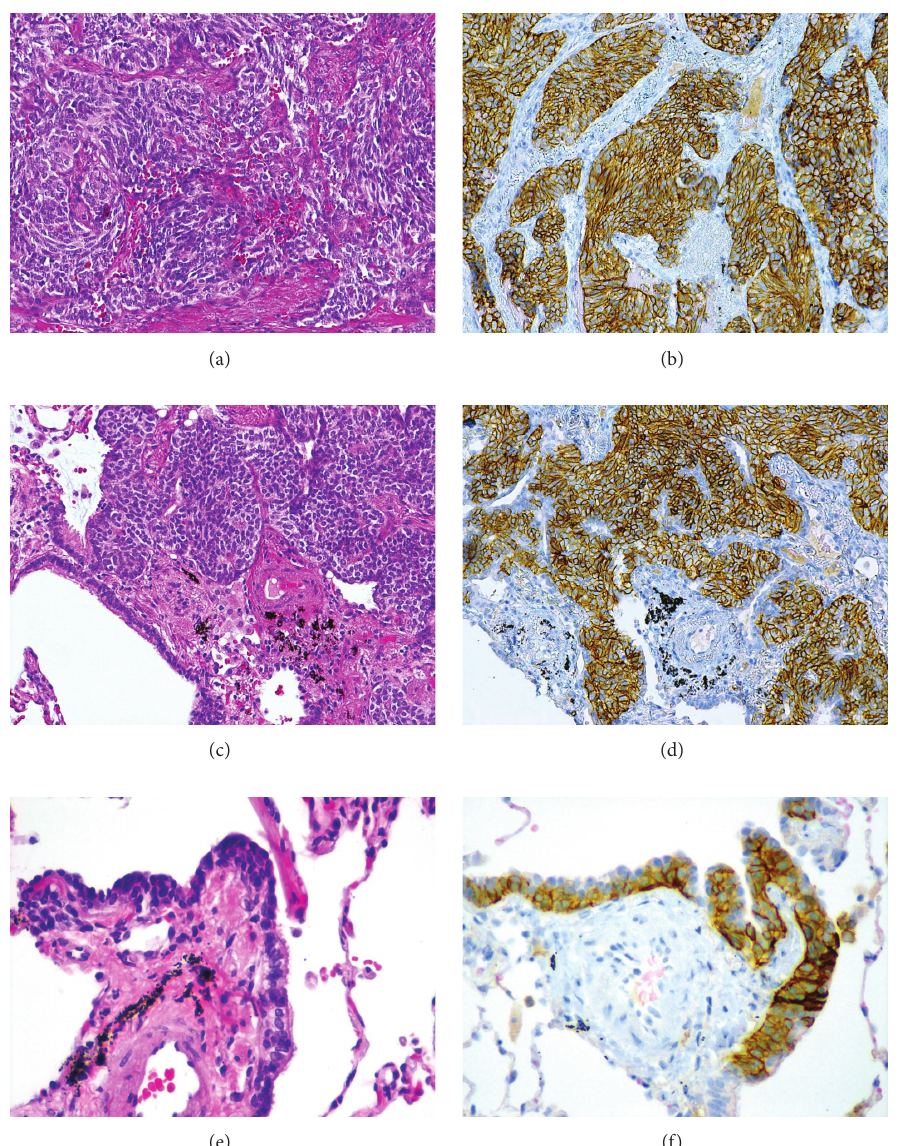
Figure 2: Case 2. (a) Carcinoid tumor. (b) Carcinoid with strong and diffuse expression of CD56. (c) Tumorlet. (d) Tumorlet also showing strong and diffuse expression of CD56. (e) DIPNECH. (f) Strong expression of CD56 in